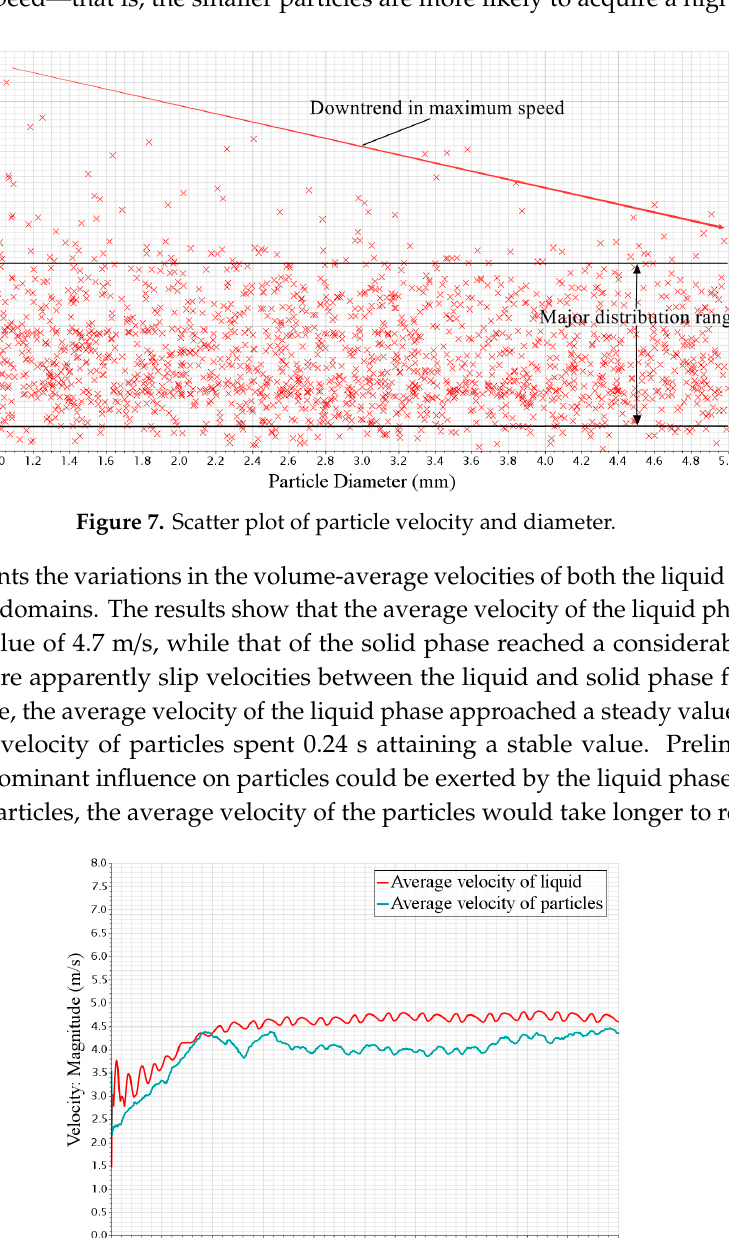
Figure 9. Histogram of the particle size to contact force.